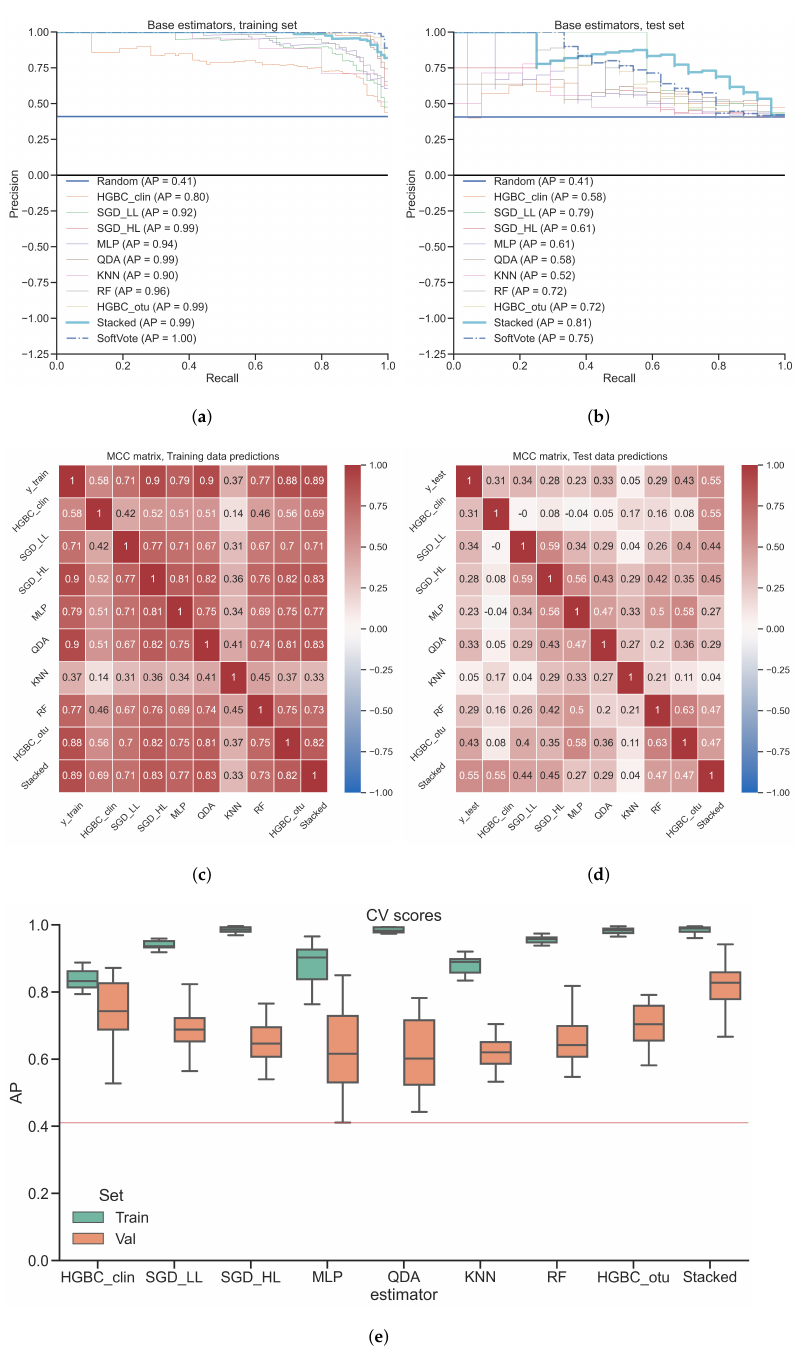
Figure 4. Model performance comparison between base learners and stacked model, colorectal cancer dataset. ( a ) PR curves and corresponding AP values of base classifiers, SoftVote classifier and the stacked classifier applied on training set; ( b ) PR curves and corresponding AP values of base classifiers, SoftVote classifier and stacked classifier applied on test set; ( c ) MCC values matrix heatmap of base classifier predictions, classification labels and the stacked classifier predictions applied on training set; ( d ) MCC values matrix heatmap of base classifier predictions, classification labels and stacked classifier predictions applied on test set; ( e ) AP values of each model during cross-validation on training and validation sets. Red horizontal line refers to AP value obtained from a random